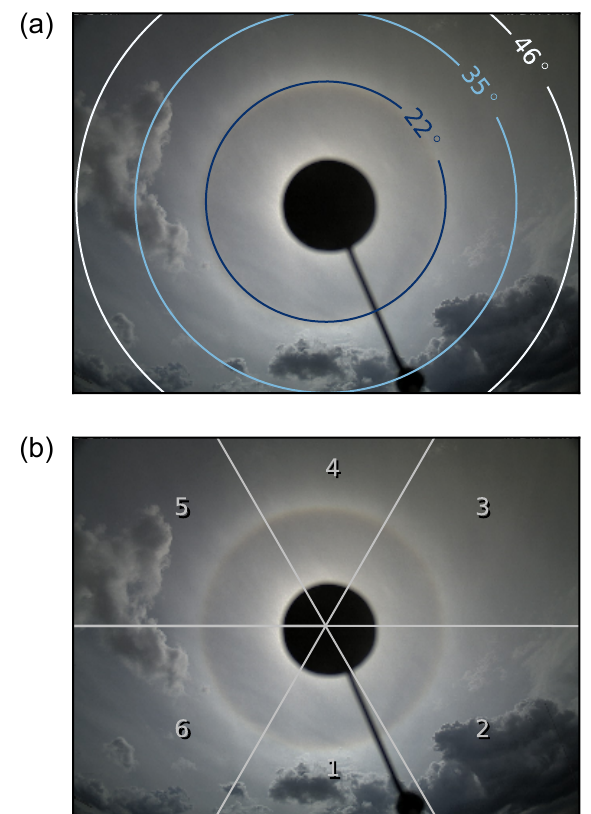
Figure 4. (a) HaloCam image from 12 May 2014, 13:52UTC, with corresponding scattering angle ( ϑ ) grid and representative contour lines at 22, 35 and 46 ◦ , (b) shows the relative azimuth ( ϕ ) grid with numbered labels for the six image segments.